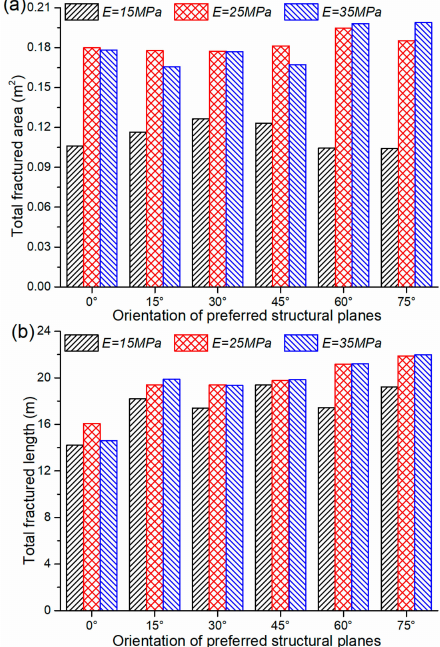
Figure 10. Total fractured area ( a ) and total length of fractures ( b ) for di ff erent elastic moduli. The boundary stress and injection rate were the same as for the base